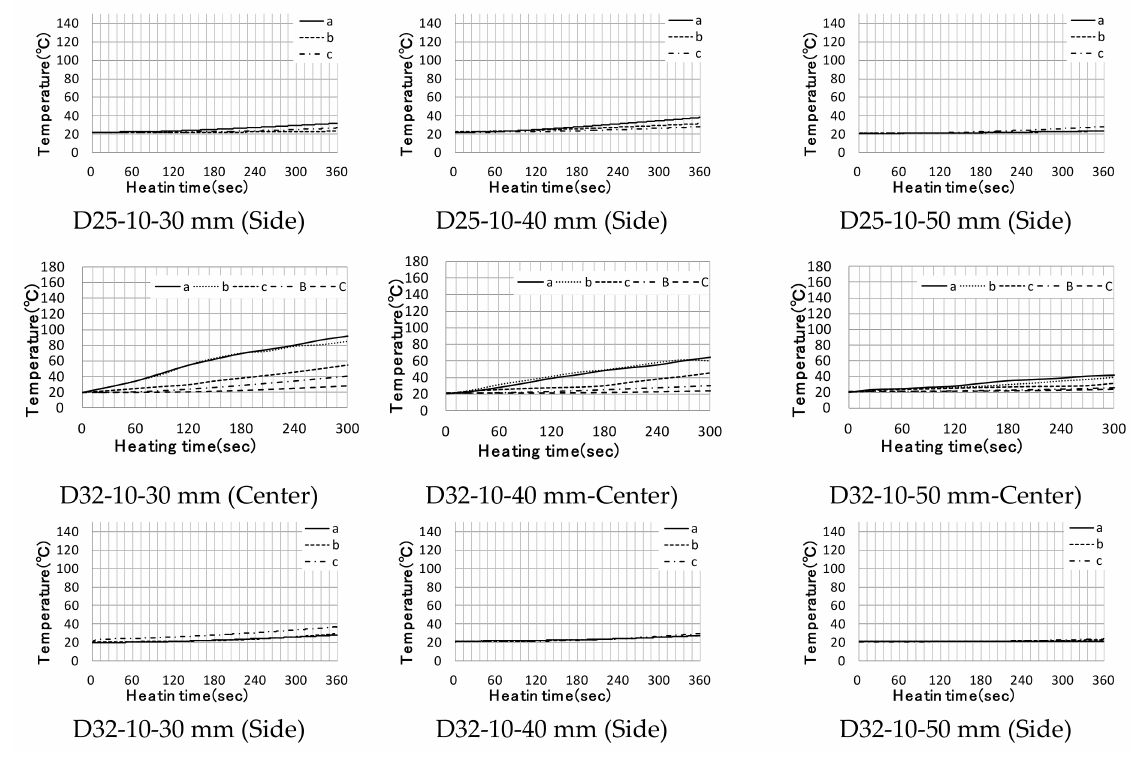
Figure 22. Temperature rising characteristics of reinforced concrete during induction